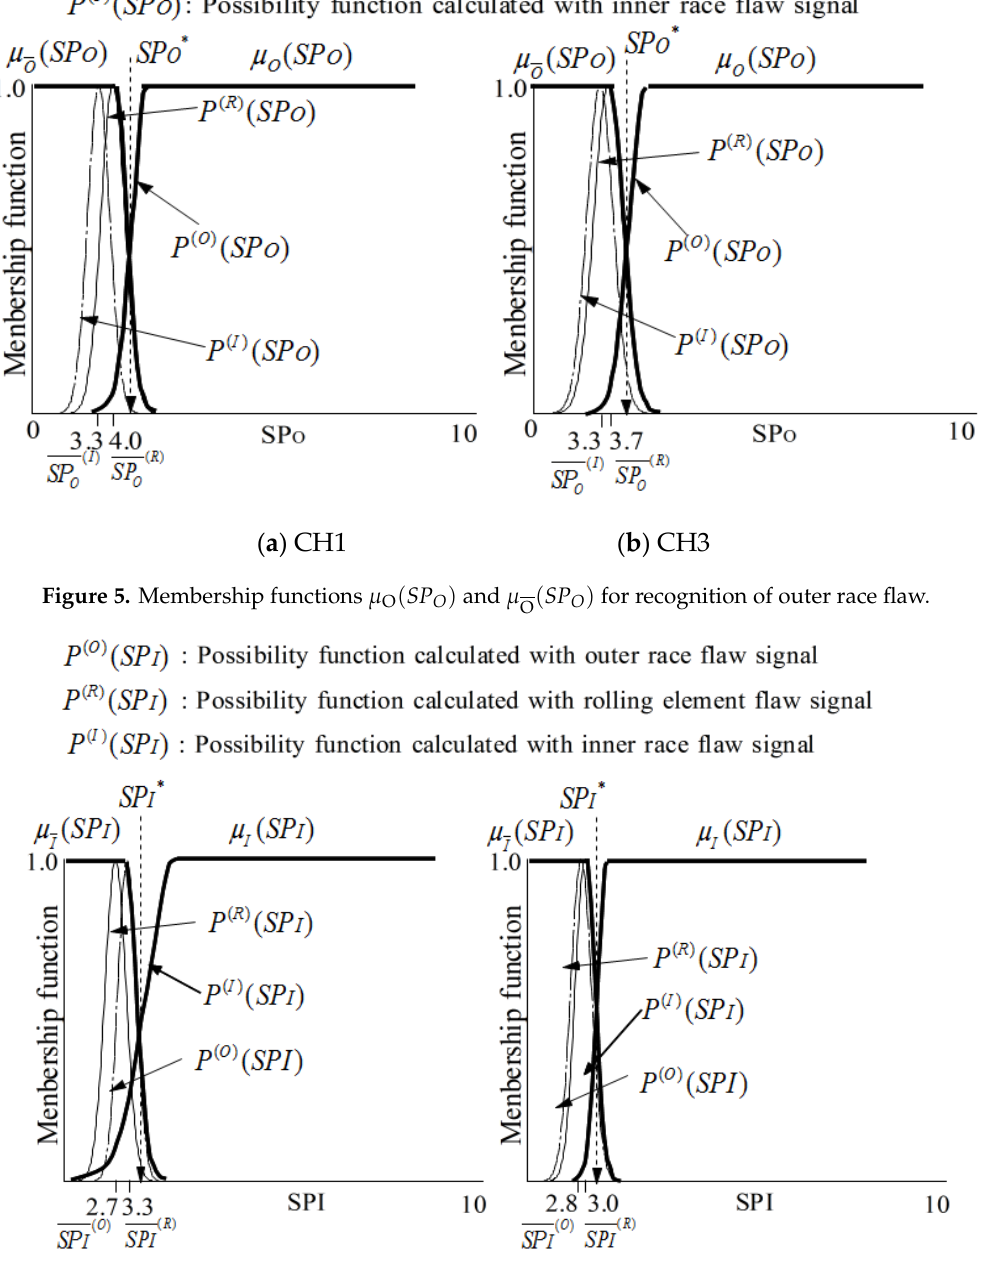
( SPI ) for recognition of inner race I